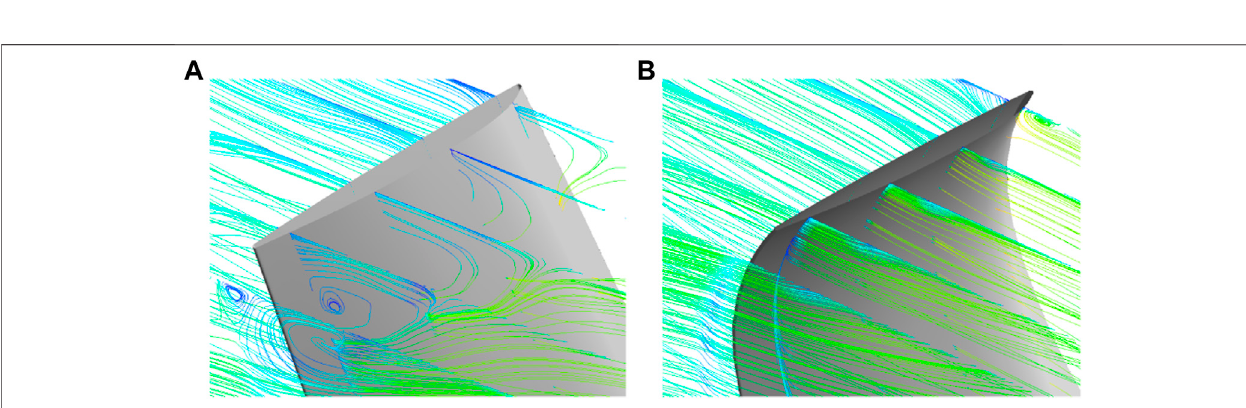
FIGURE 13 | Streamline at the blade tips: (A) traditional blade and (B) forward-swept blade.